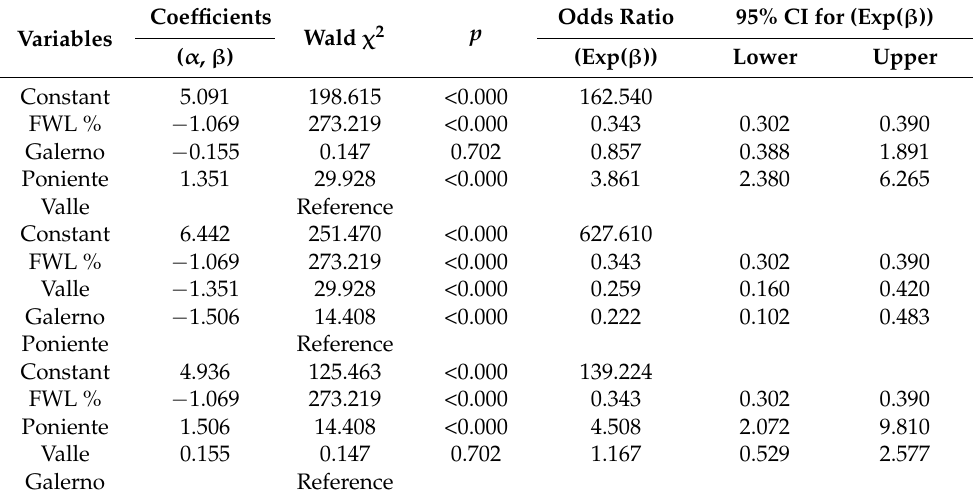
Table 8. Estimation of multiple logistic regression parameters for cucumber cultivars (Galerno, Poniente, and Valle) and fruit weight loss percentage during storage as factors influencing the probability of marketability.